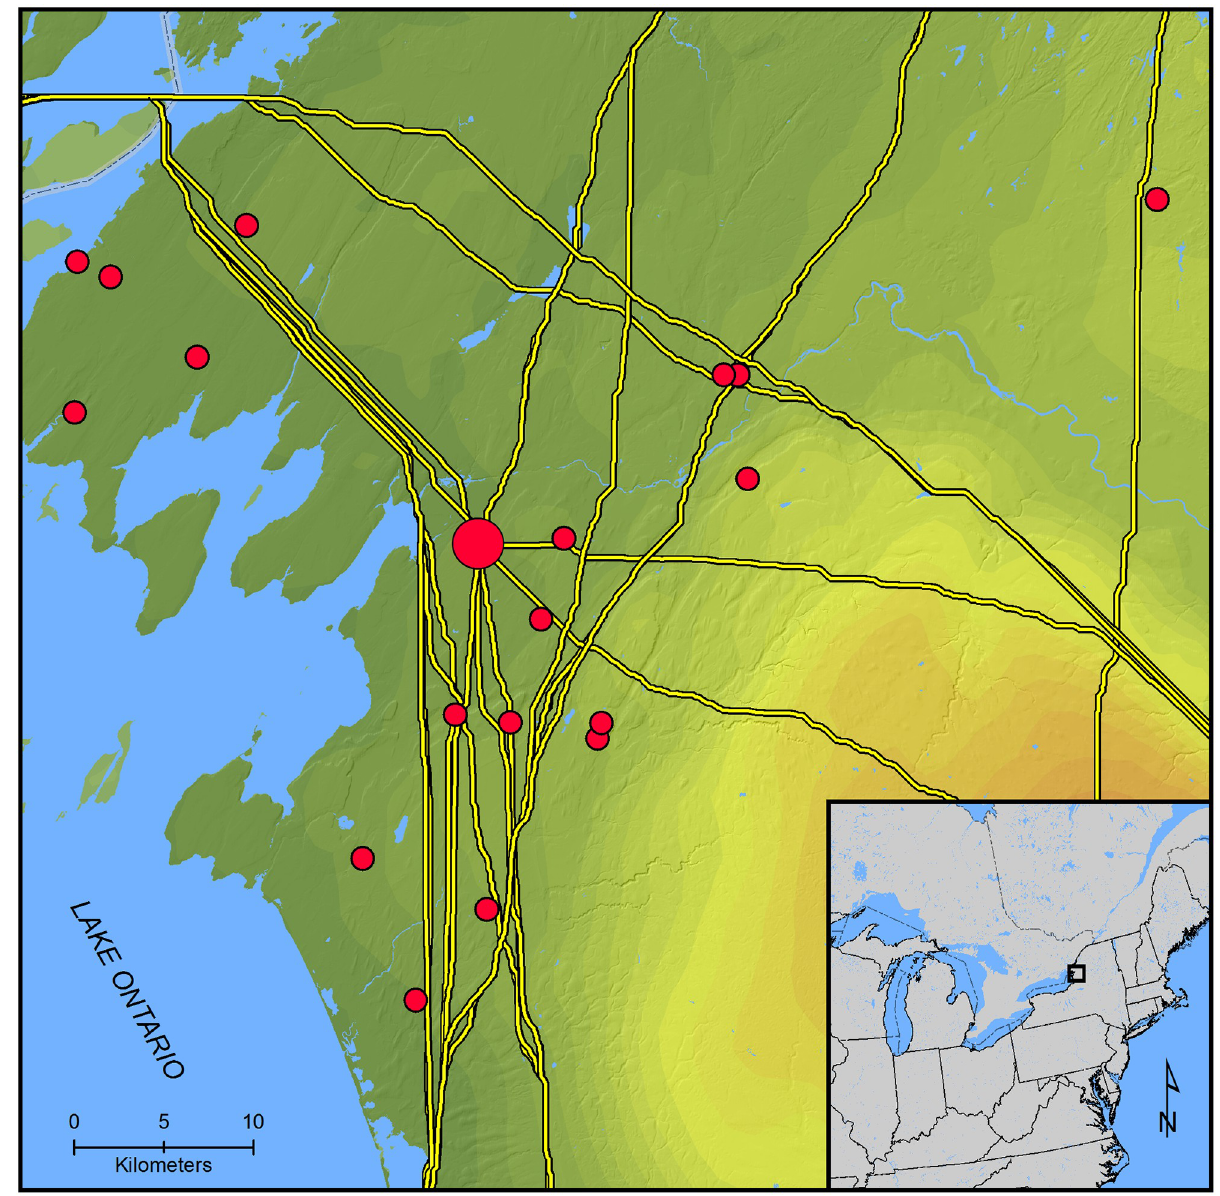
Fig 4. Jefferson County site locations and least-cost paths. The large dot is the geographic centroid, while the small dots are site locations.